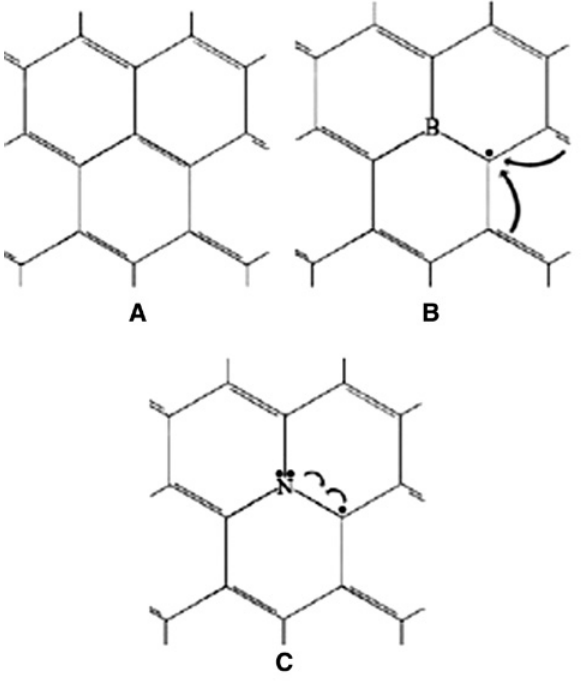
Figure 5: Illustrations of delocalized π -bonding in (A) pristine, (B) boron (B-) doped, and (C) nitrogen (N-) doped graphitic structures. (Adapted from Reference